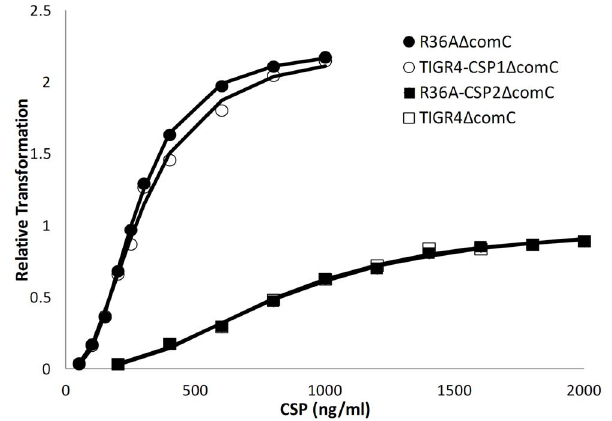
Figure 5. Comparison of the transformation efficiency of D comC strains in response to external CSP. Mutant strains were incubated with donor DNA and a gradient of their cognate CSP. Transformants resulting from each added concentration were counted as a measure of transformation efficiency. Results show that strains with ComD1 receptor present higher numbers of transformants and need less external CSP to reach the same transformation levels as their CSP2 counterparts. Plotted values are an average of 3 independent replicates and were normalized to the maximal transformation efficiency of TIGR4 D comC strain. Lines represent adjusted Hill functions, obtained through non-linear least-squares regression.